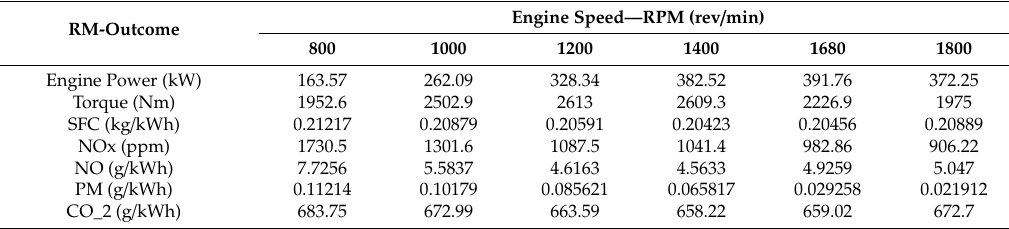
Table 5. Important outcomes of RM per engine